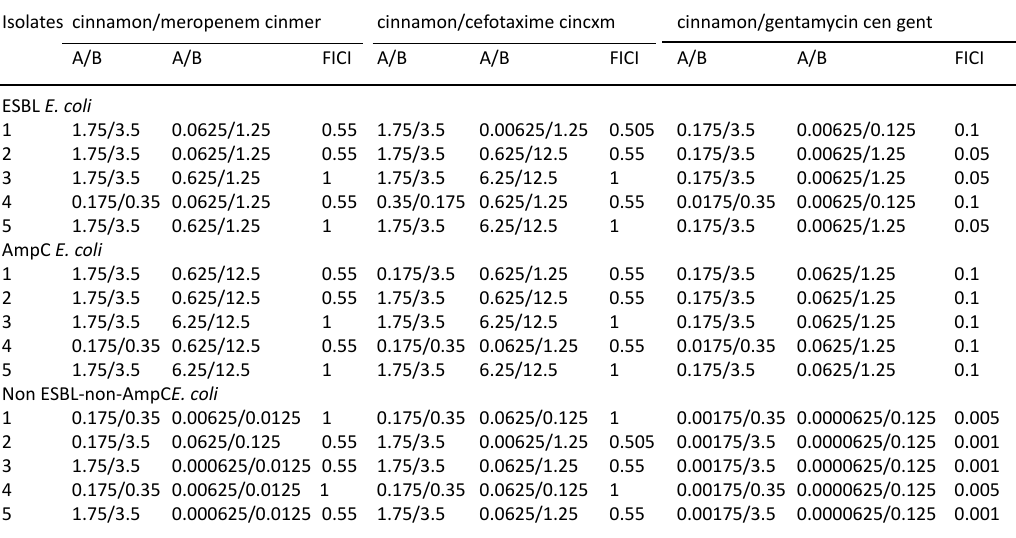
table 2 . Fractional inhibitory concentration indices (FICIs) of the 3 tested oil/antibiotic combinations Isolates cinnamon/meropenem cinmer